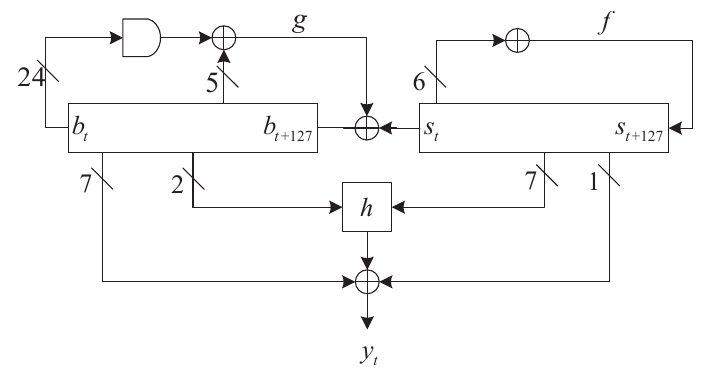
Figure 5: The overall schematic of